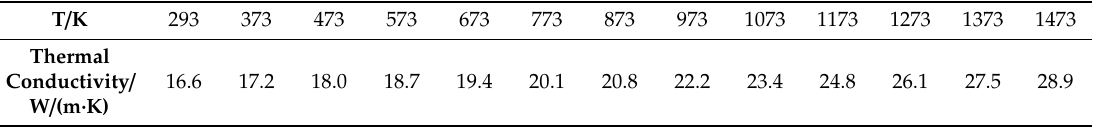
Table 1. The thermal conductivity used in simulation.